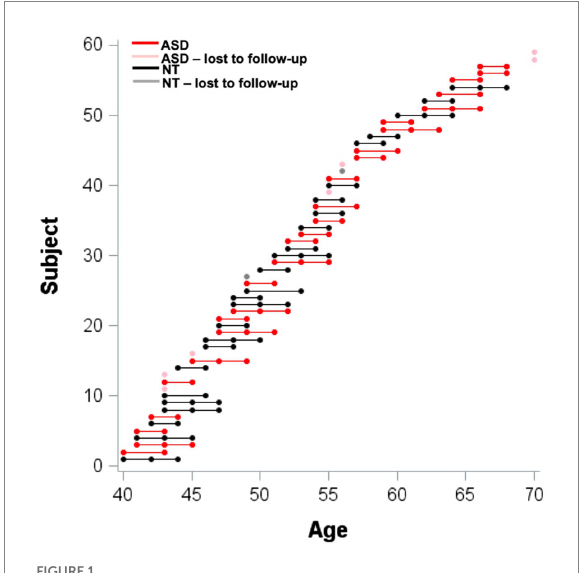
FIGURE 1 Distribution of longitudinal data as a function of